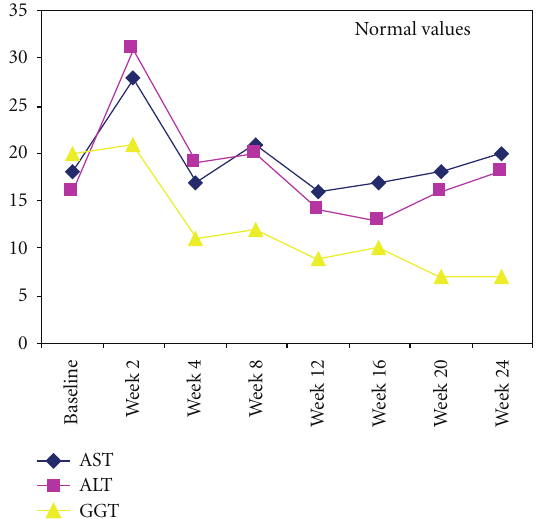
Figure 1: Levels of liver enzymes during treatment with tocilizumab.